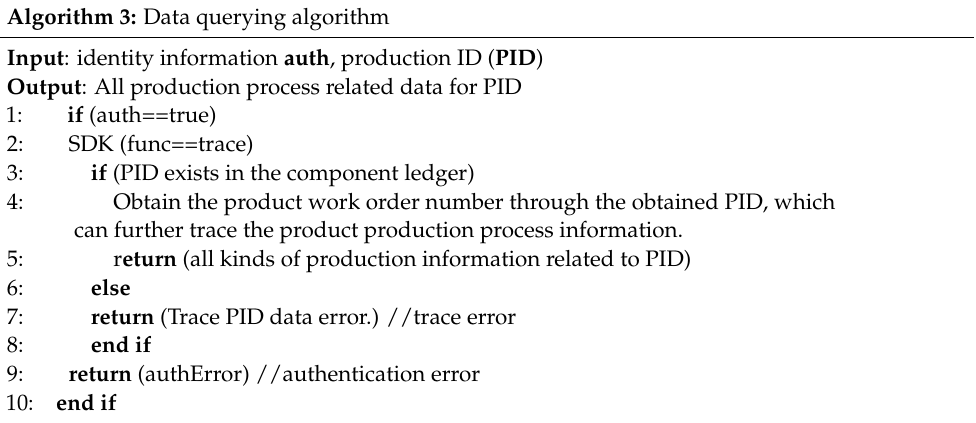
Algorithm 3: Data querying